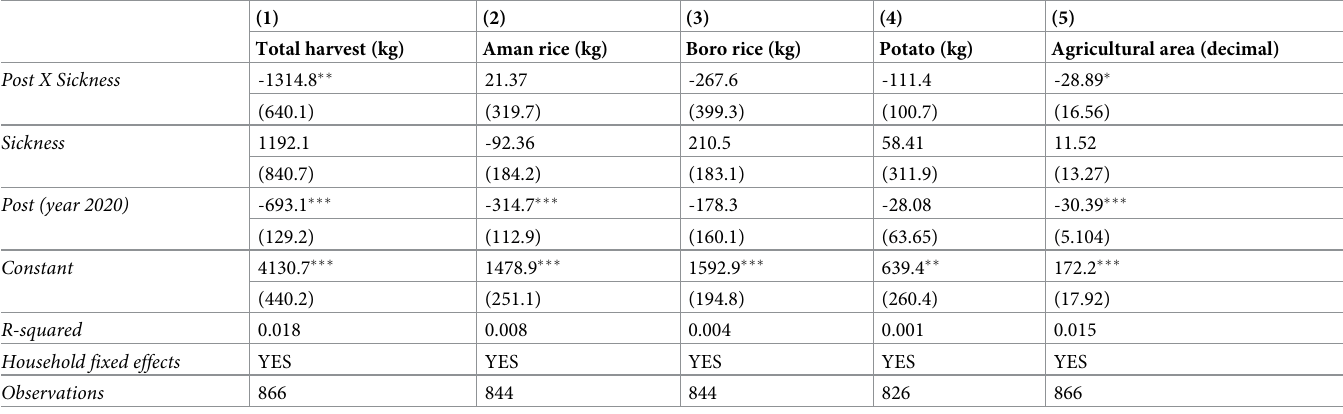
Table 4. Regression results for COVID-19 effects on agricultural production outcomes.